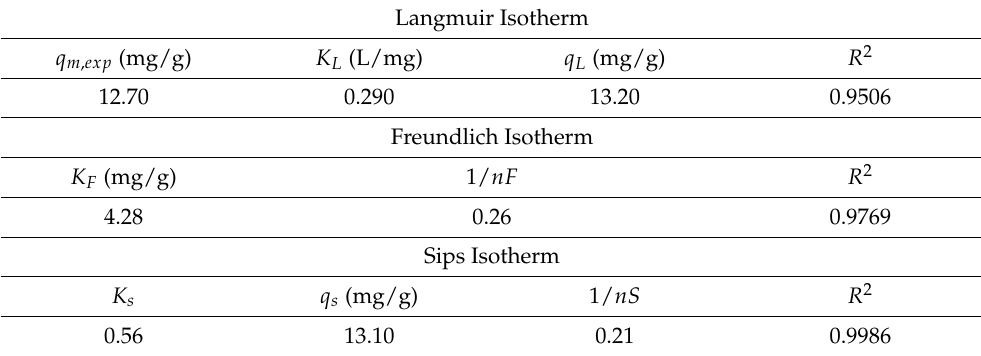
Table 5. Parameters of isotherm model for adsorption of of Au (III) onto BCb/BC.